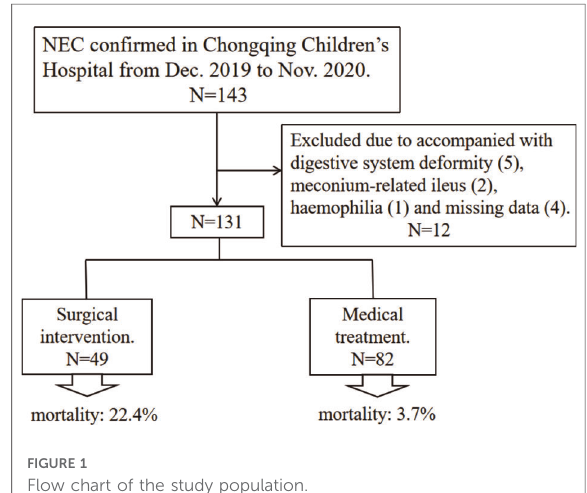
FIGURE 1 Flow chart of the study